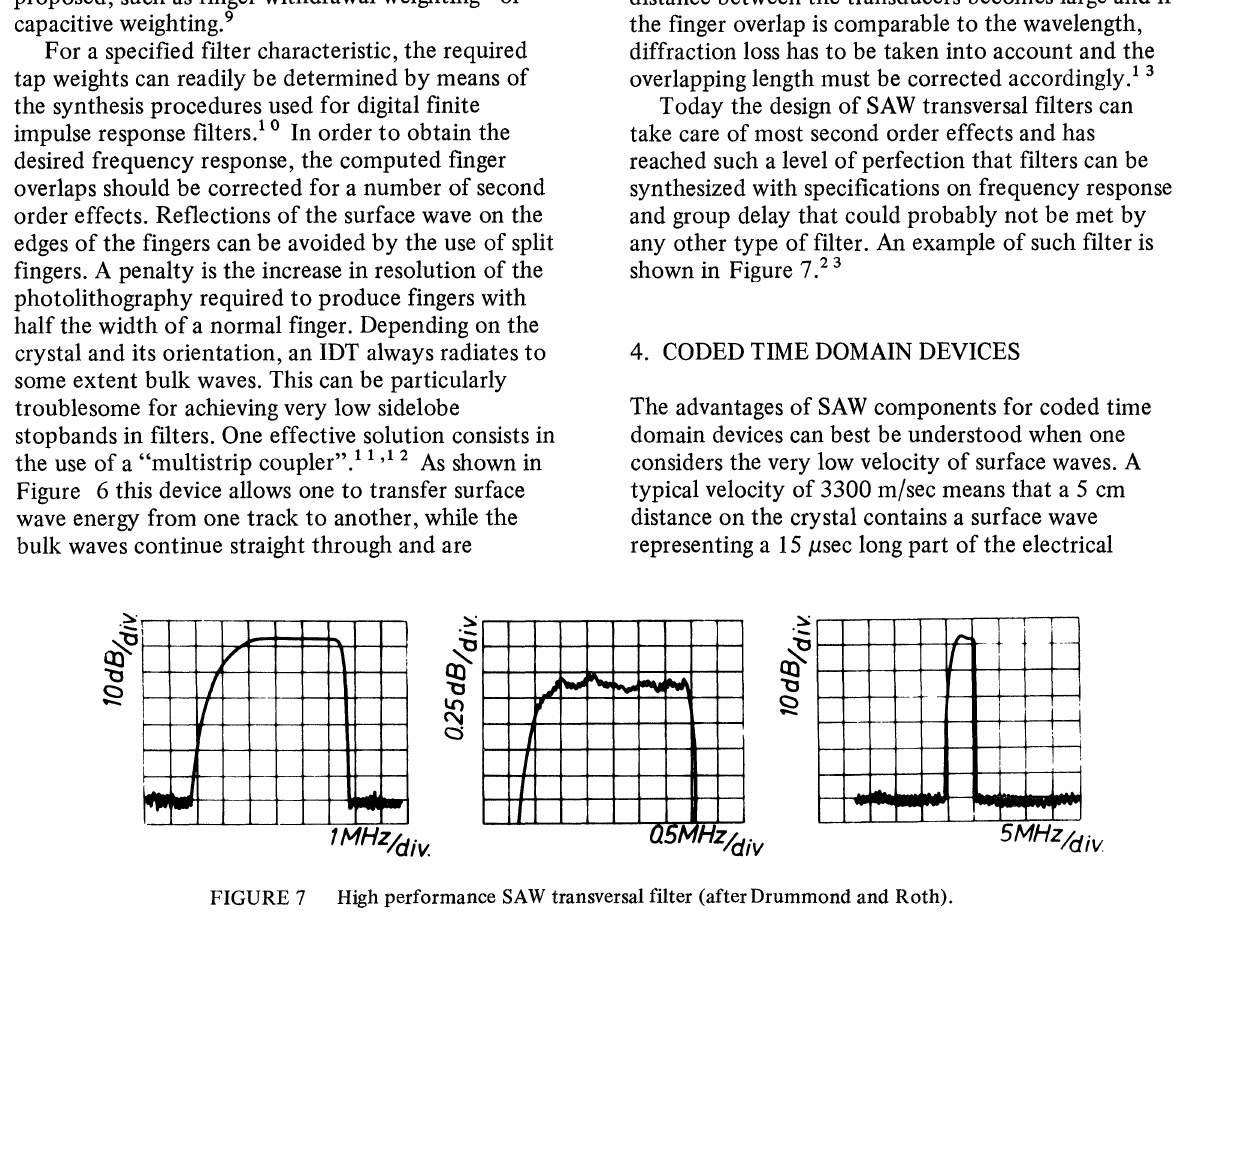
FIGURE 7 High performance SAW transversal filter (after Drummond and